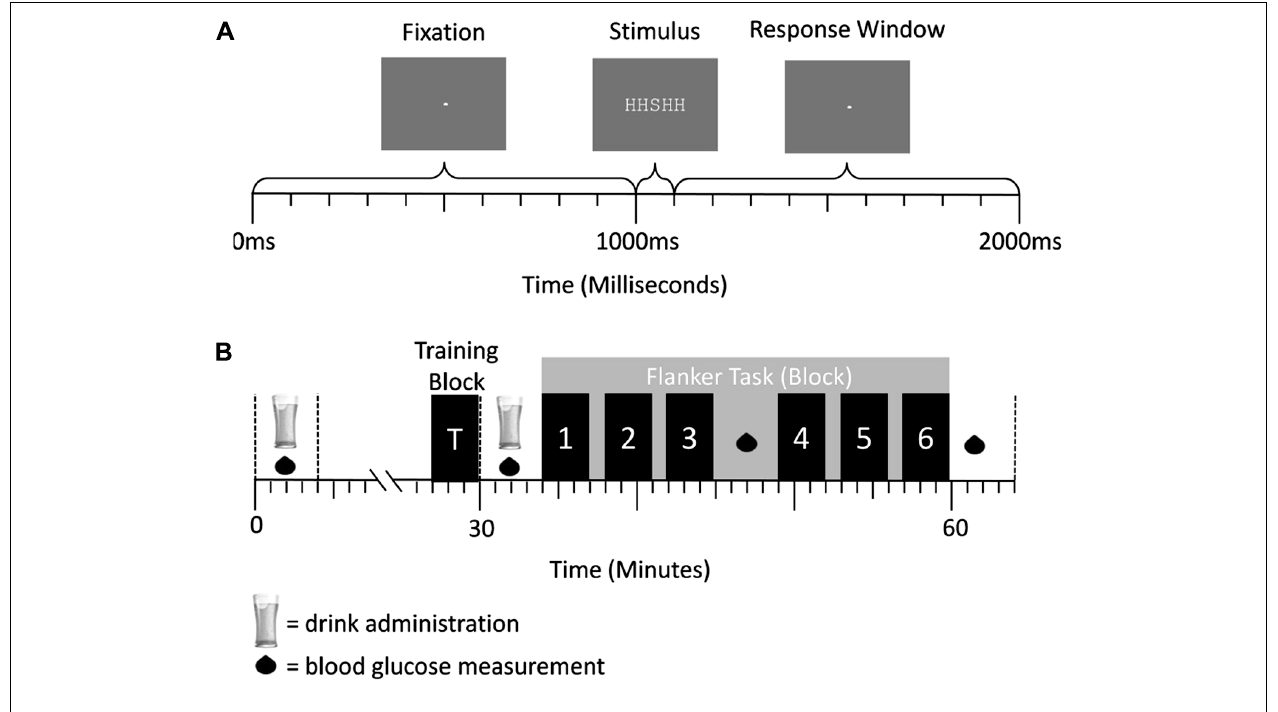
representation of a testing session. Glucose/placebo drinks were administered at 30 min intervals, while BGC measurements were taken every 15 min. The blocks of the flanker task were performed after administration of the second drink. They are represented by the numbered